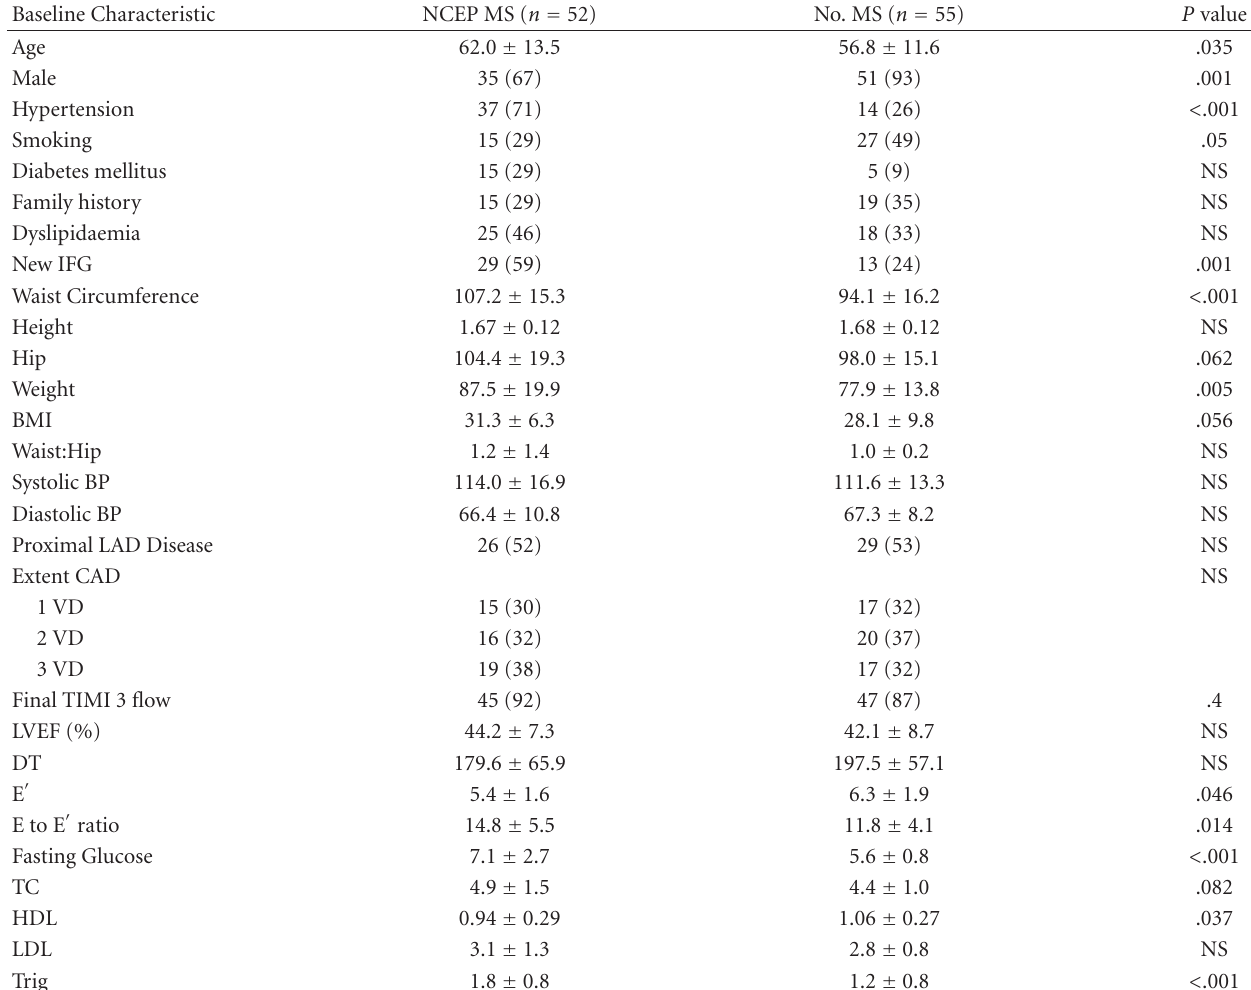
Table 3: Characteristics of patients with and without NCEP MS.